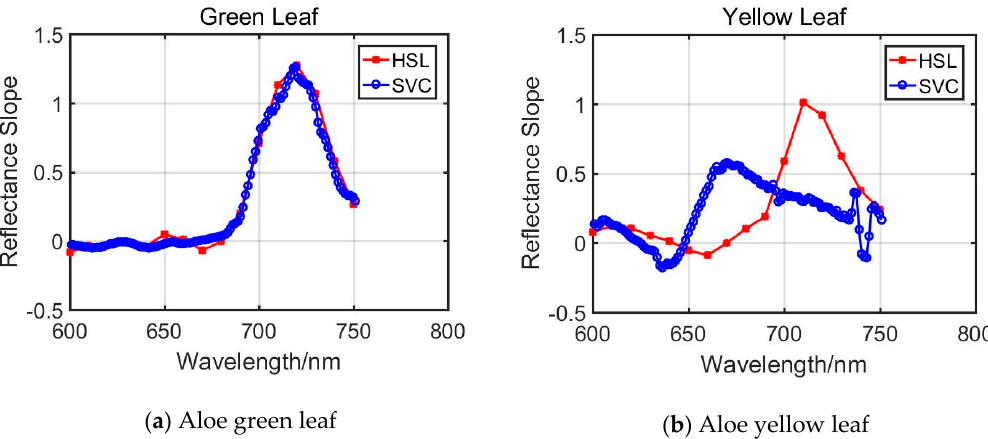
Figure 8. First derivative of the spectral reflectance versus spectral values of Aloe green and yellow leaf measured by AOTF-HSL and SVC. ( a ) Aloe green leaf, ( b ) Aloe yellow leaf.